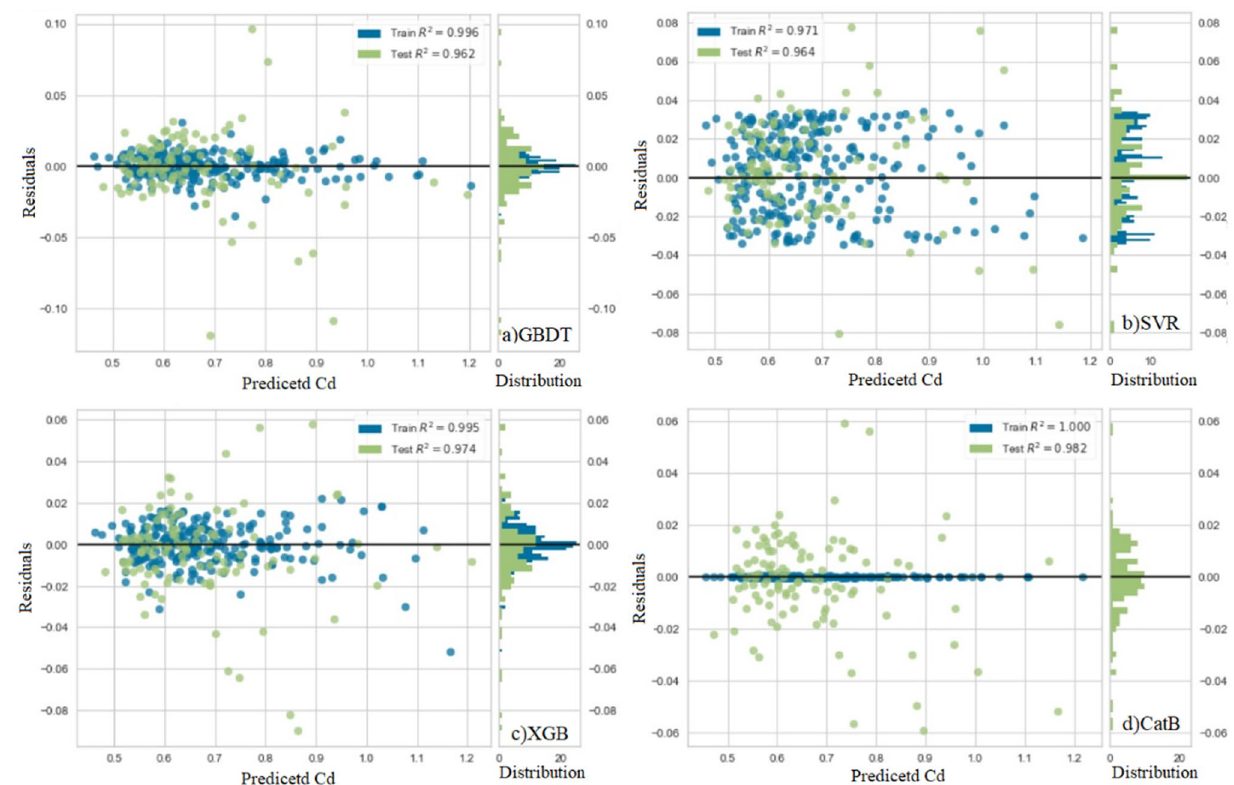
Fig. 13 Models residuals for estimation of C